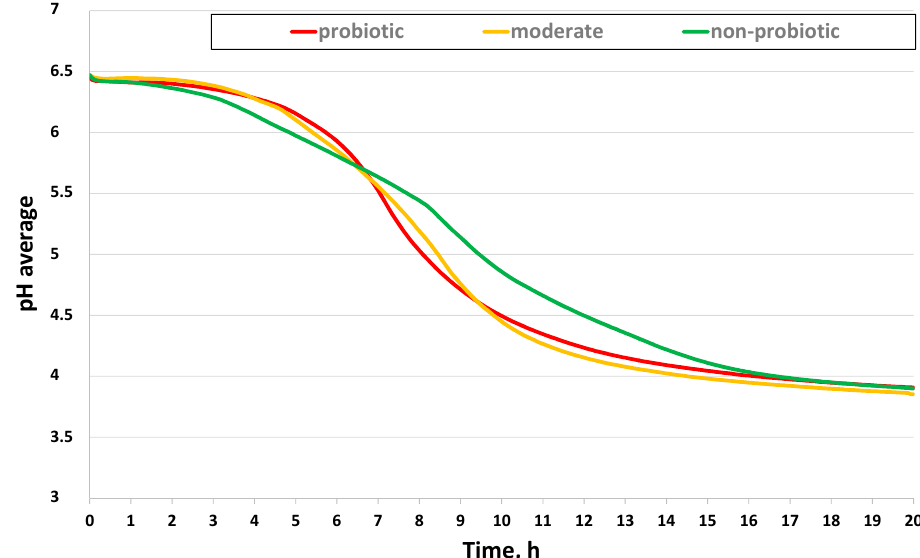
Figure 1. Average pH curves of non-probiotic, moderately probiotic, and probiotic Lactobacillus bacteria strains observed during the milk fermentation ( n = 15).